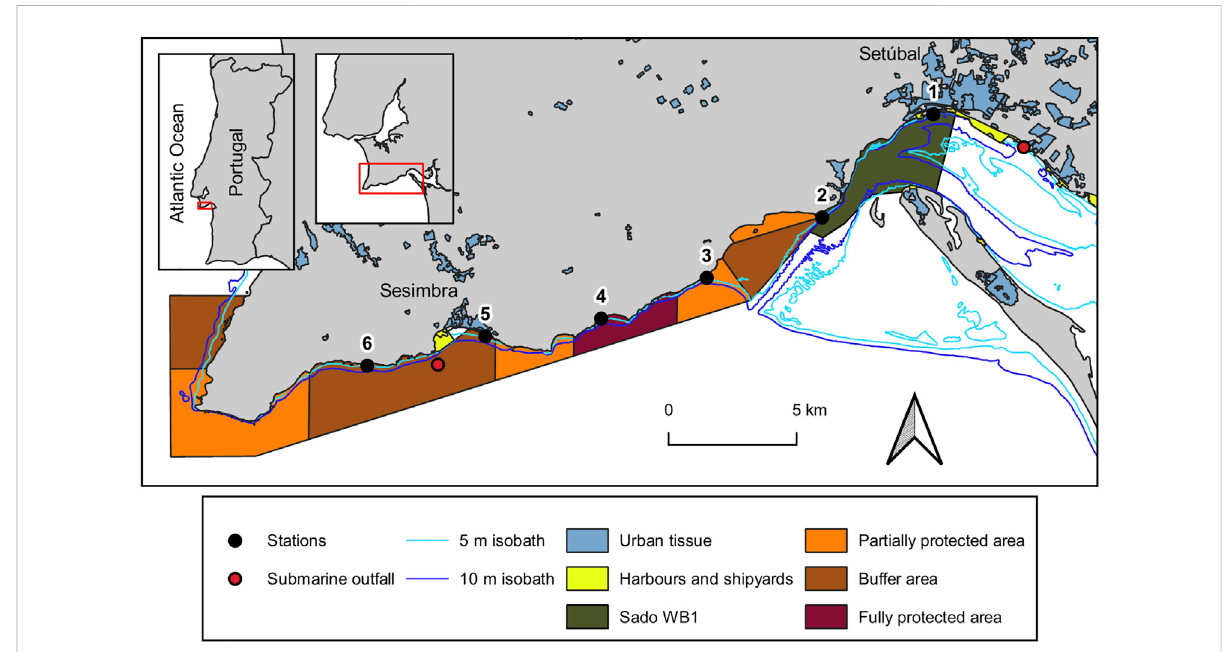
FIGURE 1 Mapofthestudyarea(developedinQGIS)withthelocationofthesixsamplingstations(blackdots)distributedalongthecoastalareaofSetúbal and Sesimbra, on the Portuguese west coast. The complete information about the map layers as well as the list with the GPS coordinates of each station are provided at the map source: Rodrigues et al.